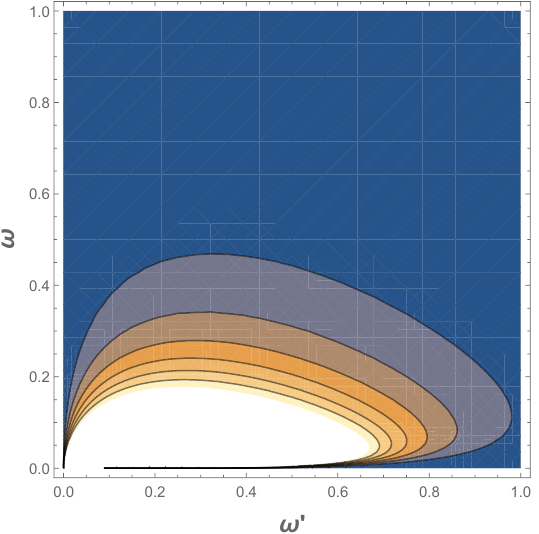
Figure 5. The Airy-Ai spectrum, | β ωω (cid:48) | 2 from Equation (21), as a contour plot, here with κ = 1. The brighter the contours the more particle production. Notice the asymmetry between ω and ω (cid:48) which are uniformly scaled. This asymmetry ultimately shows up in the infinite total particle count due to the infrared divergence of ω in N ω but makes it possible to analytically integrate N ωω (cid:48) over ω (cid:48) .